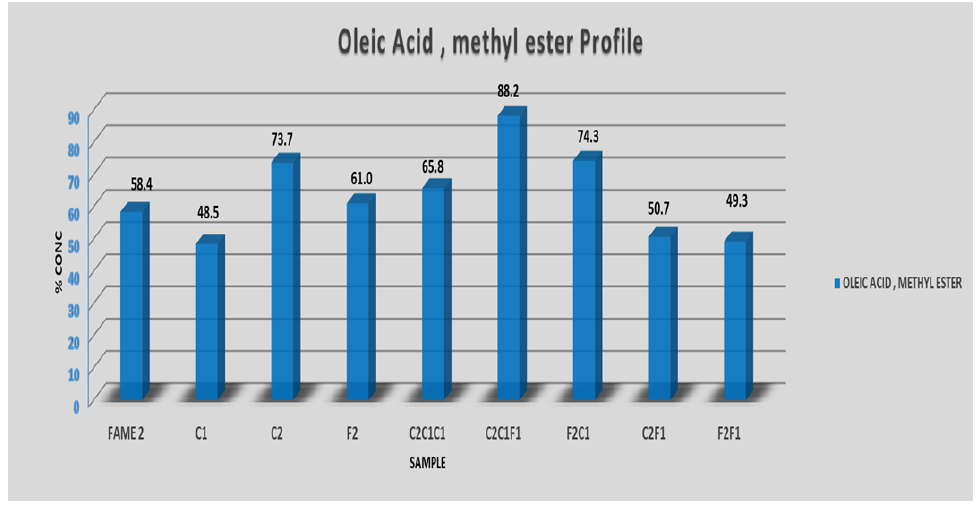
Figure 7. Concentration of oleic acid on each